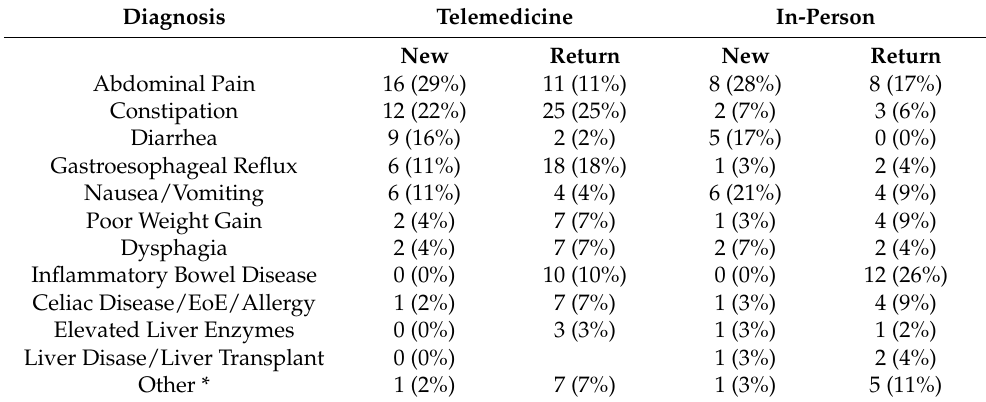
Table 3. Primary diagnosis of new patients seen in pediatric gastroenterology outreach clinics.